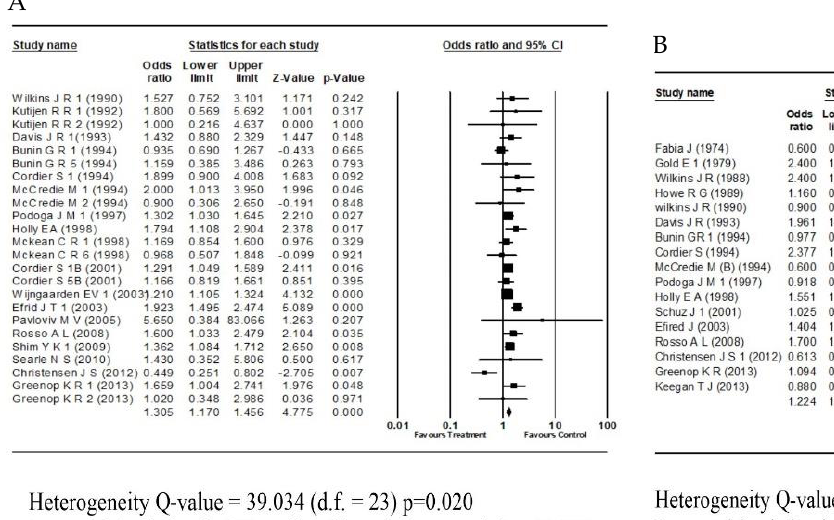
Table 2. Summary results of the statistical procedures for assessing publication biases by pesticide exposure categories. Pesticides Ex- posure